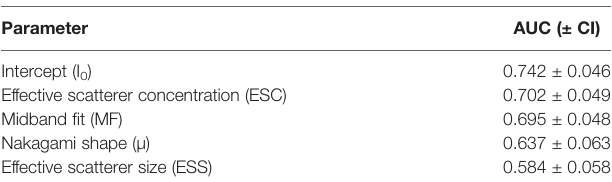
TABLE 3 | QUS parameter